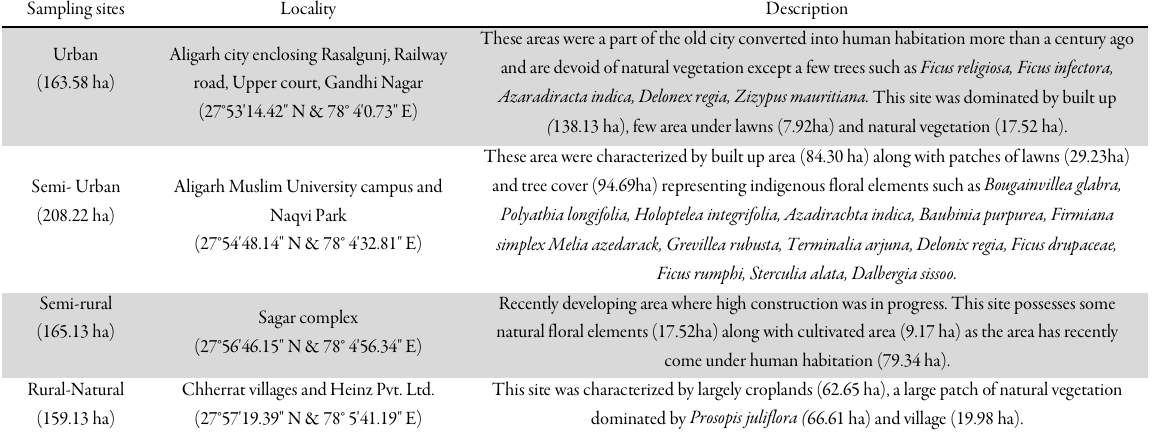
Table 1. Description of various urban-rural gradient sites in Aligarh, Uttar Pradesh, India Sampling